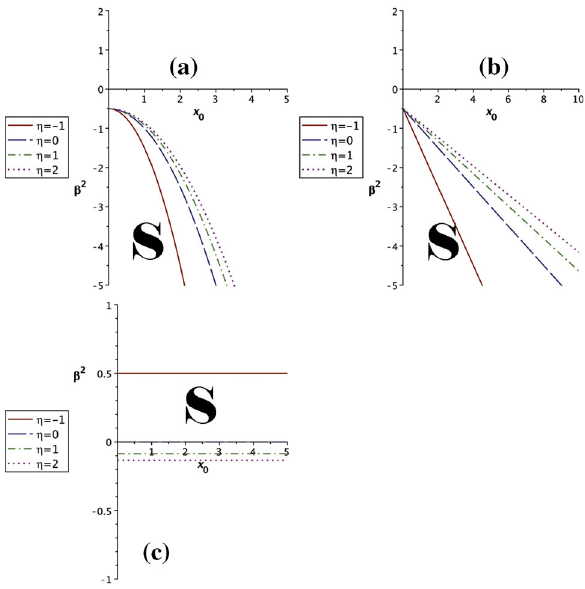
Fig. 2 β 2 versus x 0 is plotted for a CS–CS ∗ ATSW where γ is selected figure is drawn for four values of η . Note that η = 0 is associated with an M–M TSW. Also, note that η cannot adopt − 1 and the corresponding graphs for η = − 1 are brought as limits. A sign S implies the stable region